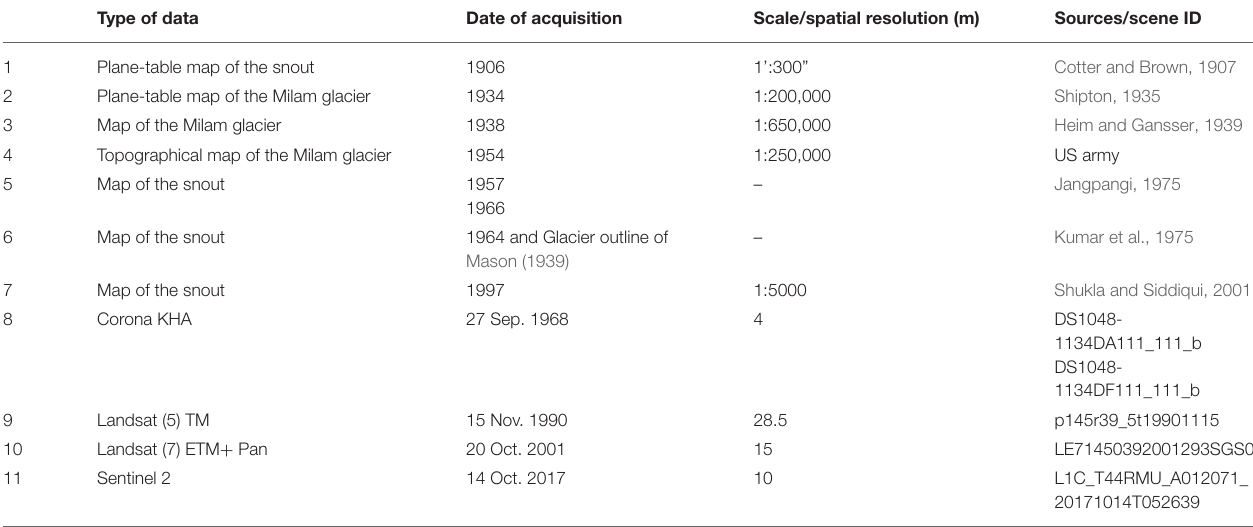
TABLE 1 | Details of data used in the present